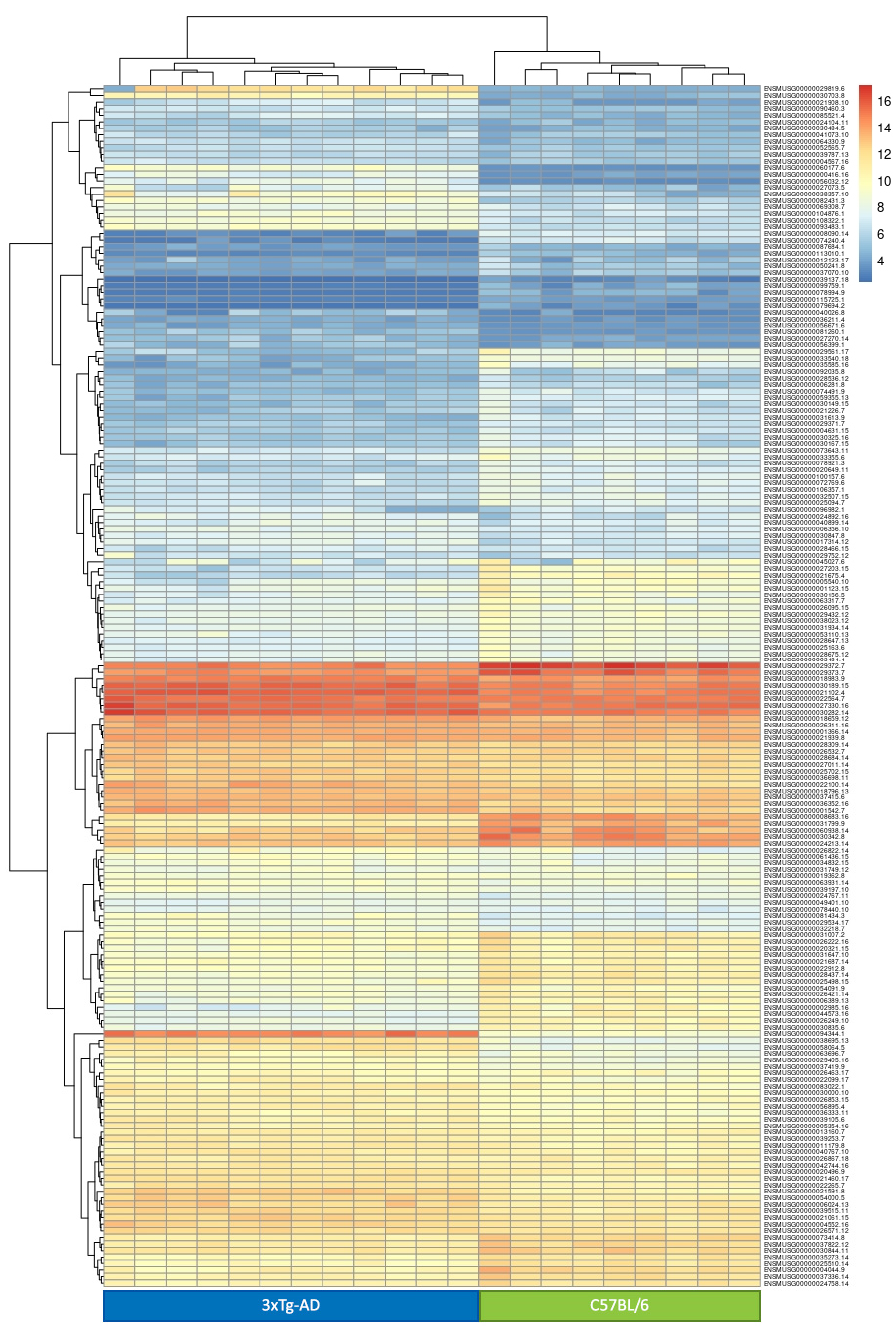
Figure 4. Heatmap of the DEGs in group